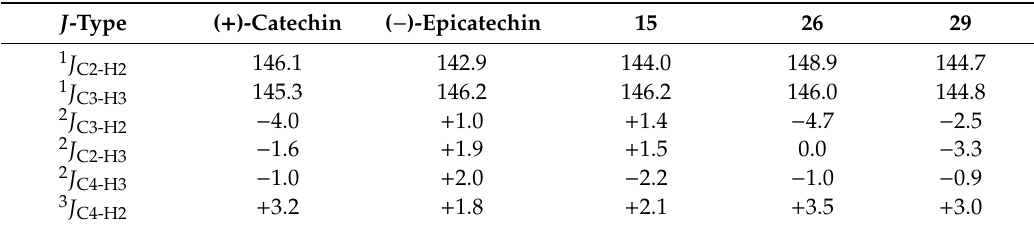
Table 3. Experimental 1 J CH , 2 J CH , and 3 J CH ( J in Hz) couplings of C-2 and C-3 for ( + )-catechin ( R , S